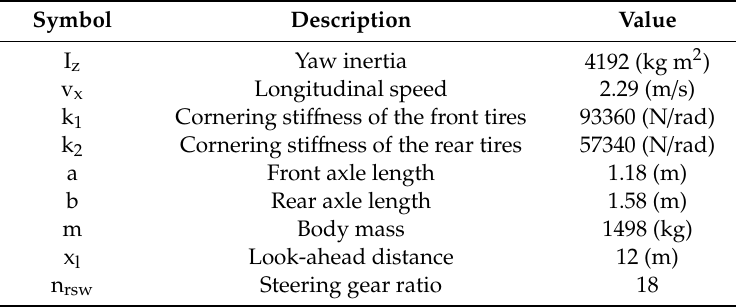
Algorithm 1. MPC controller.